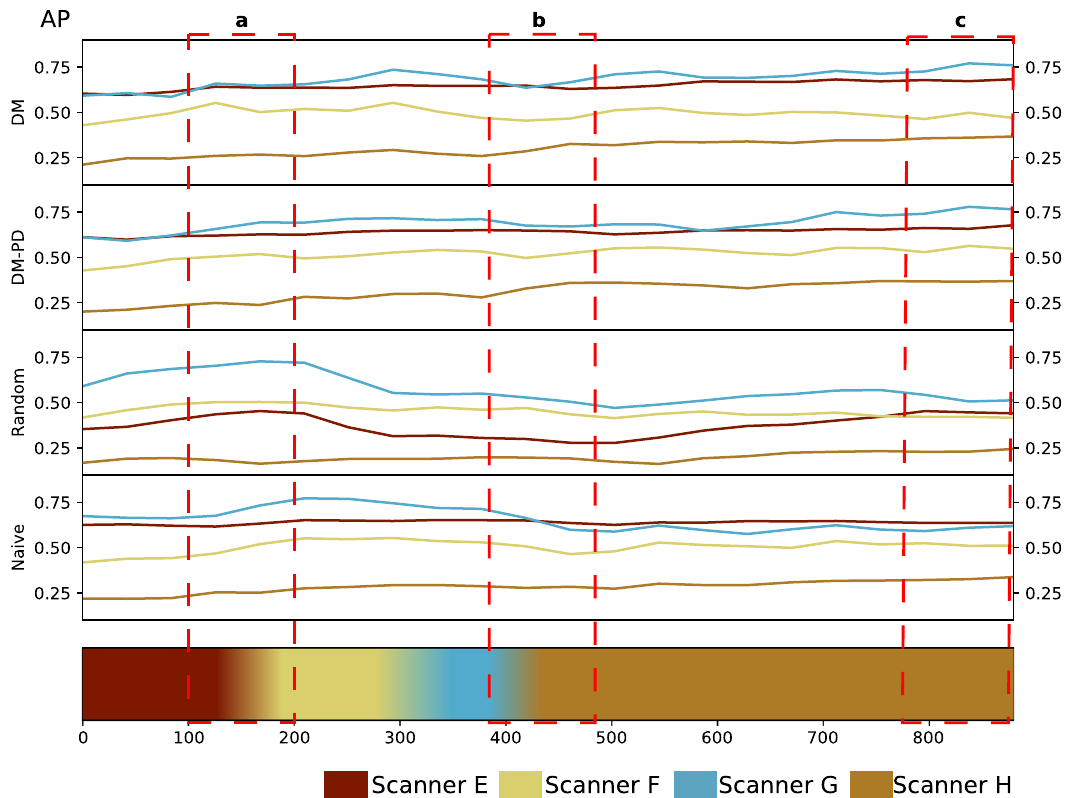
Fig. 4 Lung nodule detection. Average precision (AP) measured on the validation set during training for DM and DM-PD with M = 128 as well as a random replacement memory and naive continual learning approach. The timeline at the bottom represents the changes of domains in the data stream. a As soon as Scanner F data occurred in the stream, the validation performed on the Scanner F (and also Scanner G) domain increased for all approaches. b A clear drop in performance (AP) occurred for the naive and random replacement approach for Scanner E, F and G, after some steps of training on Scanner H data, which marked catastrophic forgetting. For DM, the performance fi rst dropped slightly, but recovered after some training steps, because samples from the memory are used for training. The DM-PD performance remained stable for Scanners E, F and G. c At the end of continual training, a better performance was achieved for Scanner E, F and G, when dynamic memory was utilized. For Scanner H, the performance for all three approaches was similar. d The performance for Scanner E was stable during the entire continual training process for all approaches, showing a base training that was saturated for scanner